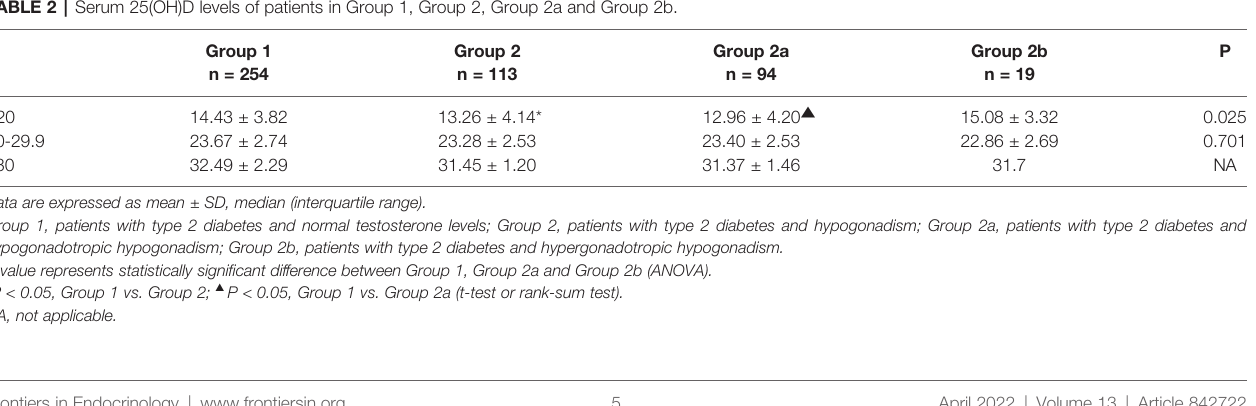
TABLE 2 | Serum 25(OH)D levels of patients in Group 1, Group 2, Group 2a and Group 2b.